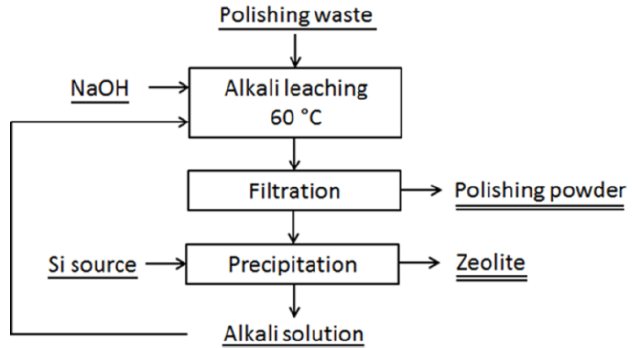
Figure 6. Alkali leaching of polishing powder for the recovery of polishing powder followed by recovery of silica and alumina as zeolite from leach solution. Adapted from Kato et al. [12], with permission from American Chemical Society, 2018.